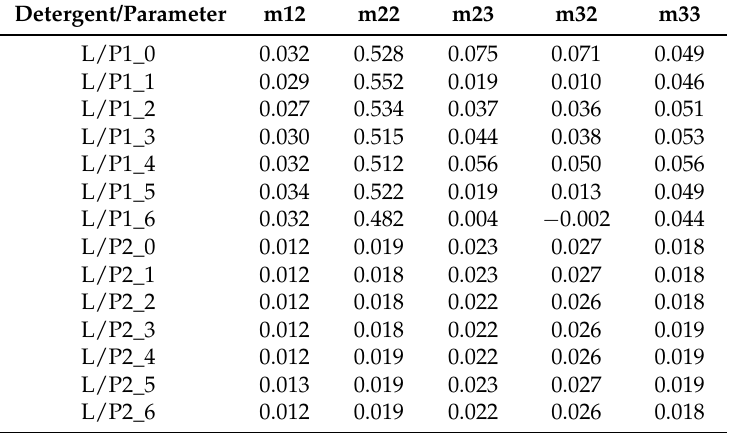
Table 2. Central moments P1 and P2 of the Mueller matrix elements for silk sample washed by laundry powder.